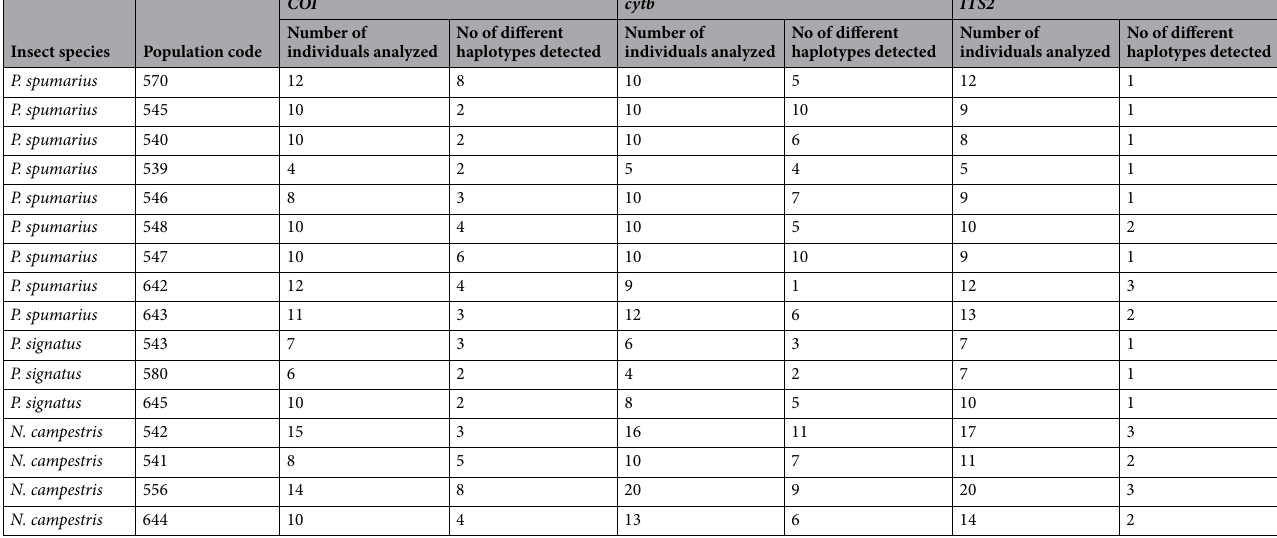
Table 1. Total number of individuals within each population of the three insect-species examined for genetic analysis and total number of haplotypes detected within each population, for each molecular marker